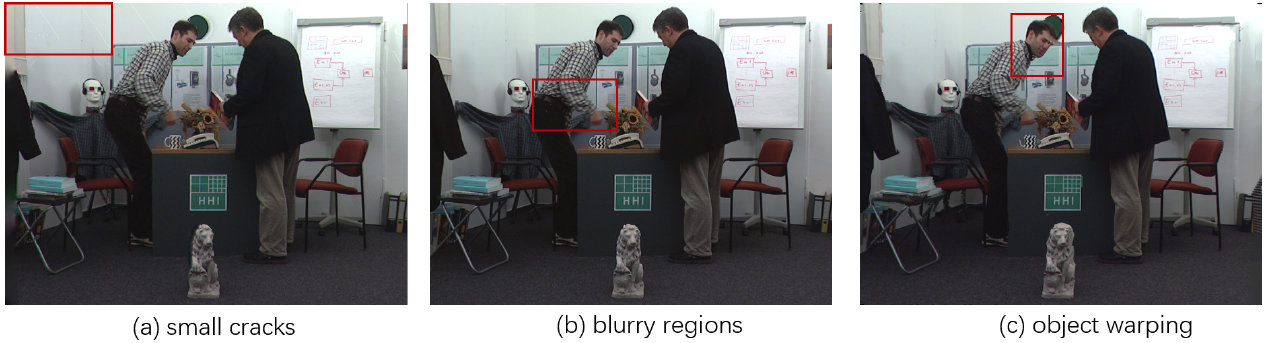
Figure 1. Some examples of distortions in the DIBR